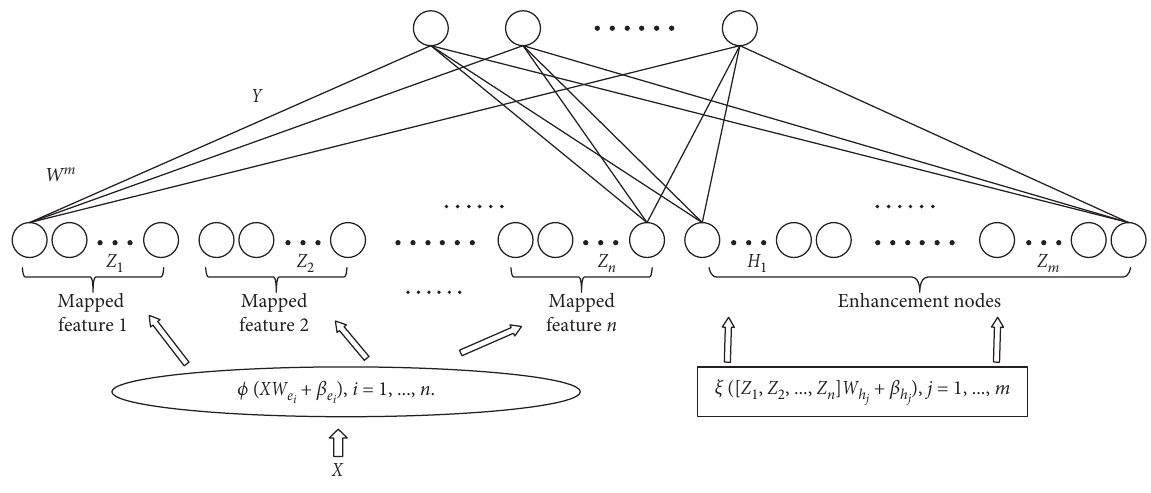
Figure 2: The BLS structure.